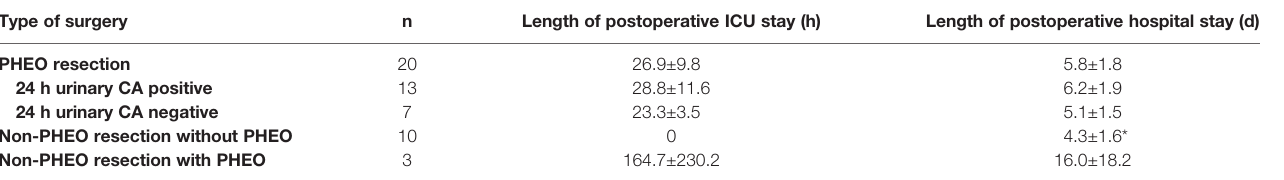
TABLE 3 | Length of ICU stay and postoperative hospital stay after different types of surgery in MEN2A patients. Type of surgery n Length of postoperative ICU stay (h) Length of postoperative hospital stay